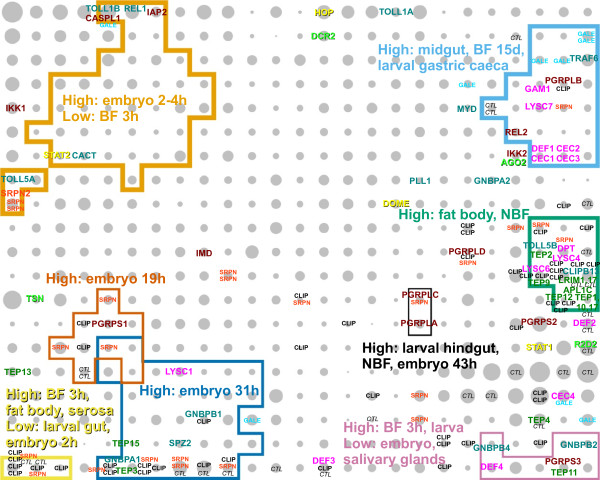
Immunity genes are highly localised. Genes belonging to various immunity-related pathways and gene families are shown on the map. Toll pathway members are labeled in dark cyan, the IMD pathway in dark red, JAK/STAT pathway in yellow, siRNA pathway in bright green, anti-microbial peptides and effectors in magenta, and LRIM1, APL1C and TEPs are labeled in dark green. CLIP-domain serine proteases, serpins, C-type lectins and galectins are shown generically in black, light red, black italic and cyan respectively. Several regions of the map that are rich in immunity genes are outlined and described by their dominant gene expression characteristics.